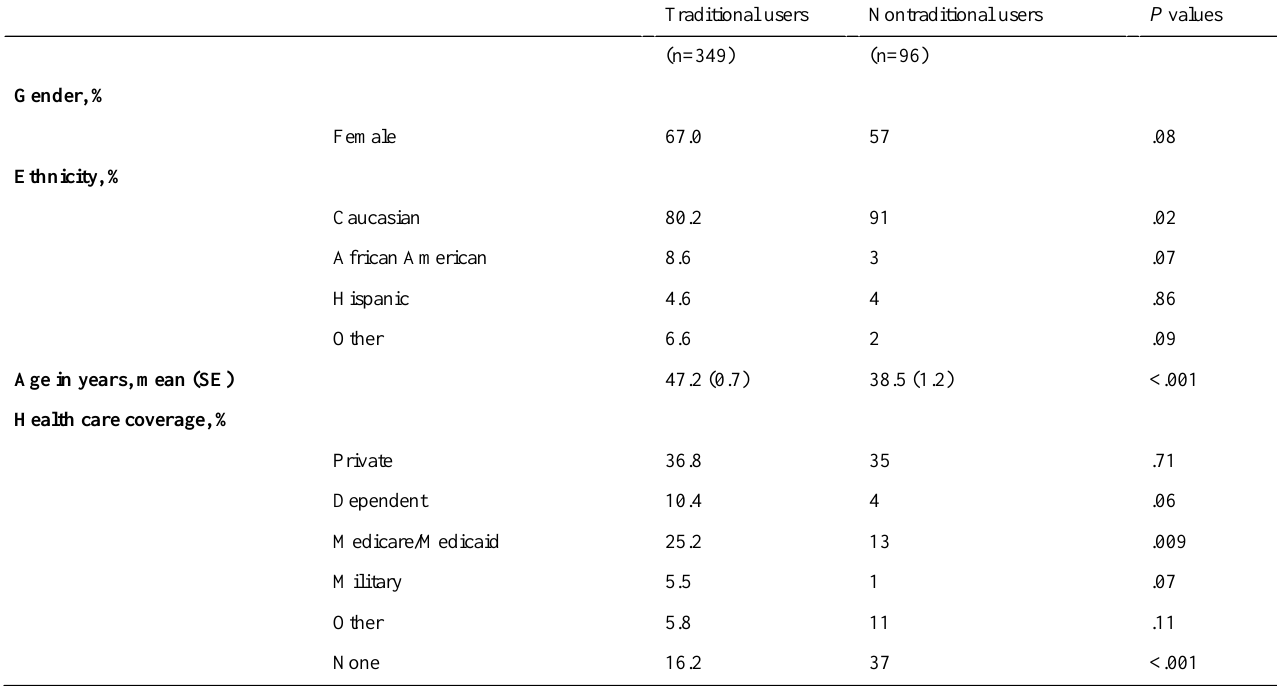
Table 1. Demographics and health information for traditional and nontraditional